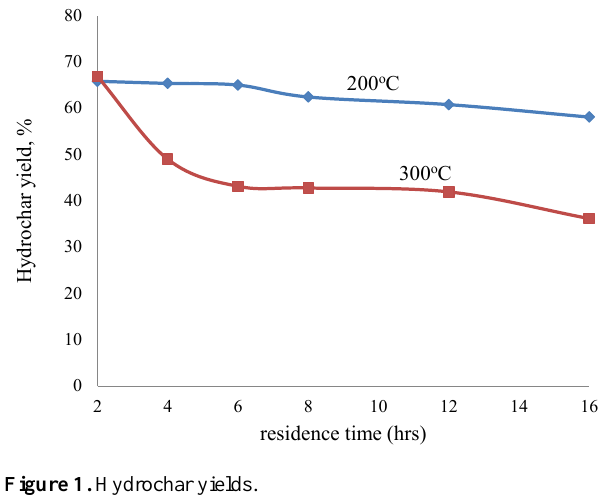
Figure 1. Hydrochar Figure 1 . Hydrochar yields